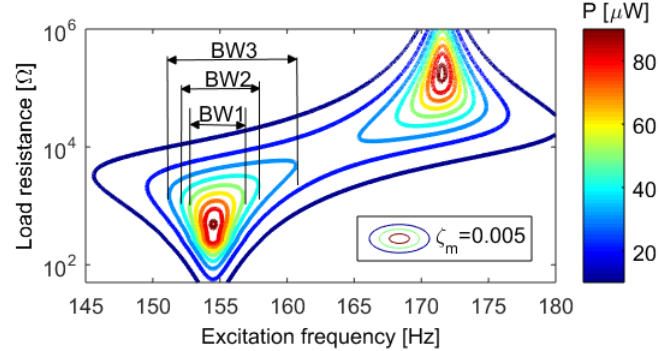
Figure 13. Different bandwidths at different power levels.